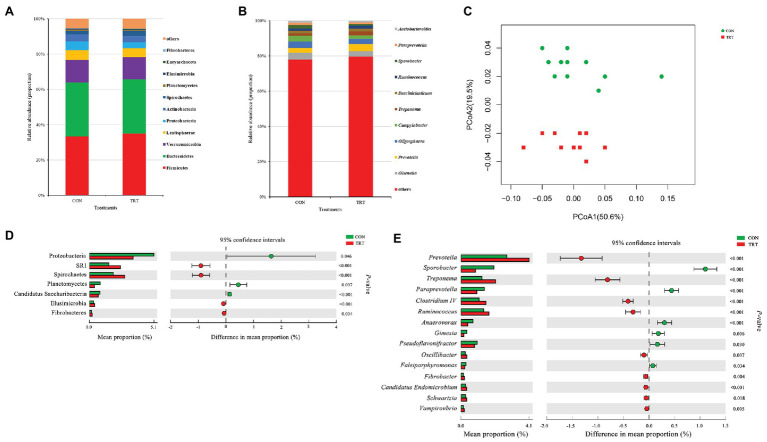
Changes in bacteria community structure. (A) The composition of the predominant bacterial phyla. (B) The composition of the predominant bacterial genera. (C) PCoA of bacterial community structure. (D) Difference in the relative abundance of bacterial phyla. (E) Difference in the relative abundance of bacterial genera. CON, the control group fermentation substrate, corn stover; TRT, the treatment group fermentation substrate, steam-exploded corn stover (n = 12).